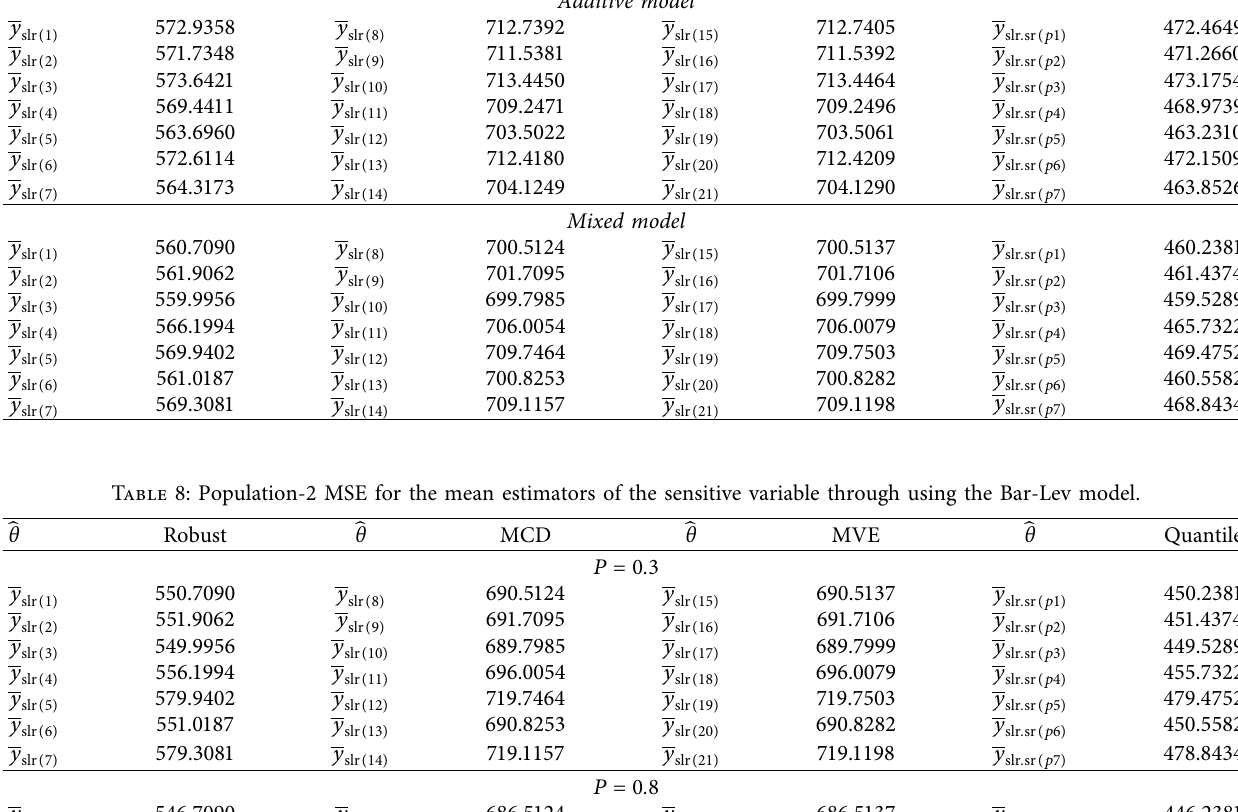
Table 7: Population-2 MSE for the mean estimators of the sensitive variable through using the additive and mixed models. 􏽢 θ Robust 􏽢 θ